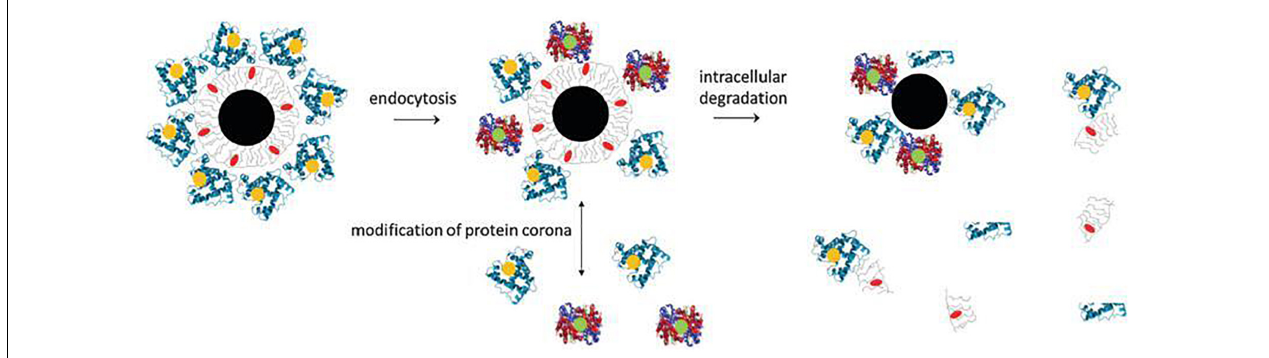
FIGURE 6 | Composition and in vivo degradation of a tupical inorganic NP (Feliu et al., 2016). A typical inorganic NP comprises of an inorganic core (black), a engineered surface (gray) and a shell of adsorbed biological molecules (blue). During the degradation process, the nanoparticles may break down into individual components. The inorganic core may begin to decompose first, changing its physical and morphological characteristics. The engineered organic coating can also be partly removed by intracellular